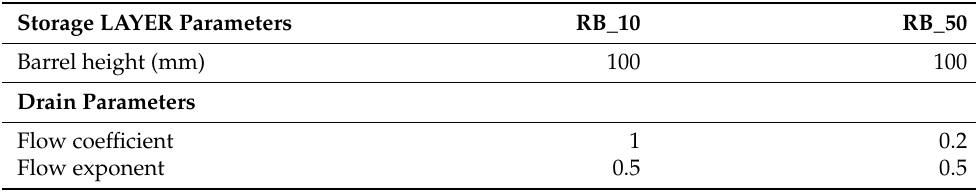
Table 1. Floodable streets and industrial squares simulated as rain barrel LID control: input parame-